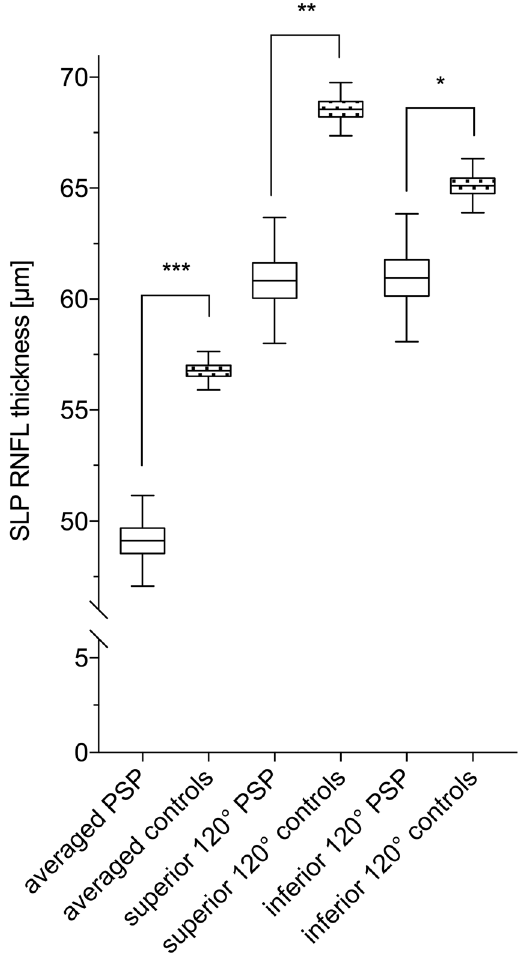
Figure 3. RNFL thickness data of PSP patients and controls measured by SLP is depicted. Significantly different sectors are shown. ns: not significant p > 0.5, * p ≤ 0.5, ** p ≤ 0.01, *** p ≤ 0.001.